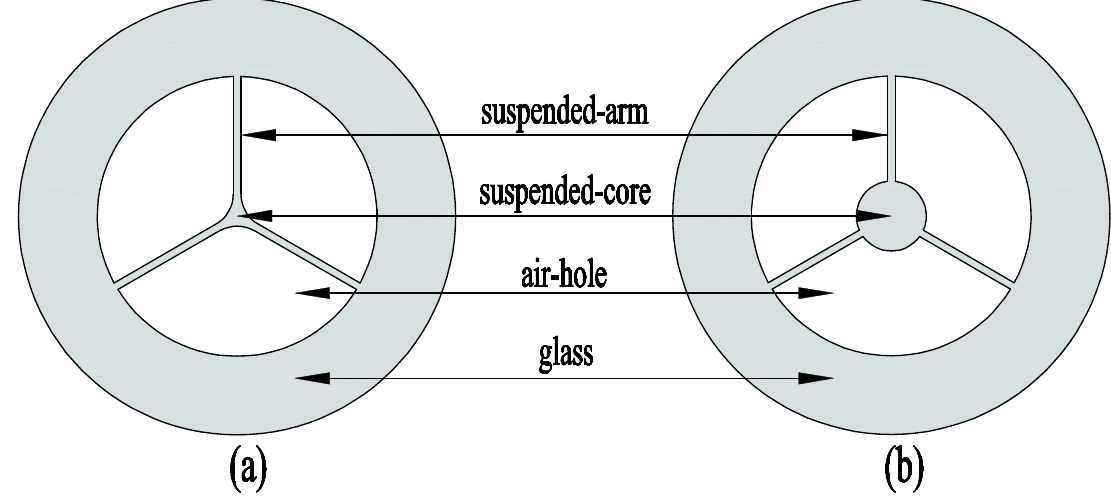
Figure 1. Two di ff erent types of suspended-core fibers (SCFs). ( a ) SCF with non-independent core ( b ) SCF with non-independent core.